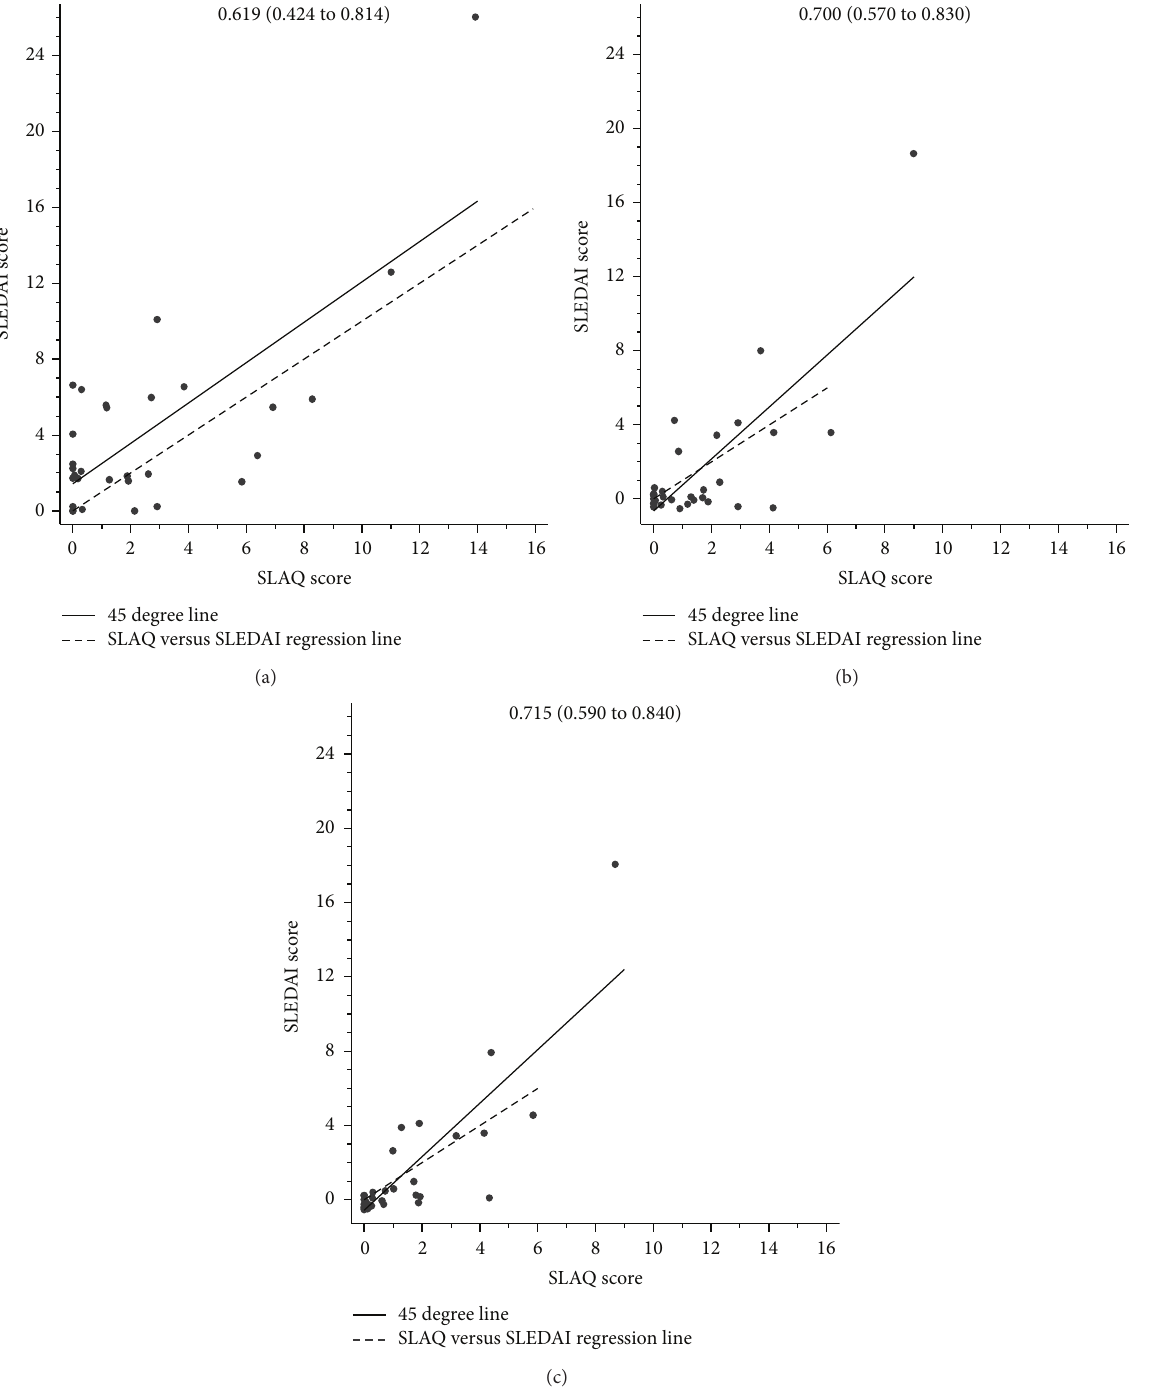
Figure 1: The concordance between (a) the original activity scores, (b) the matched-items score, and (c) the scores further restricted by recall